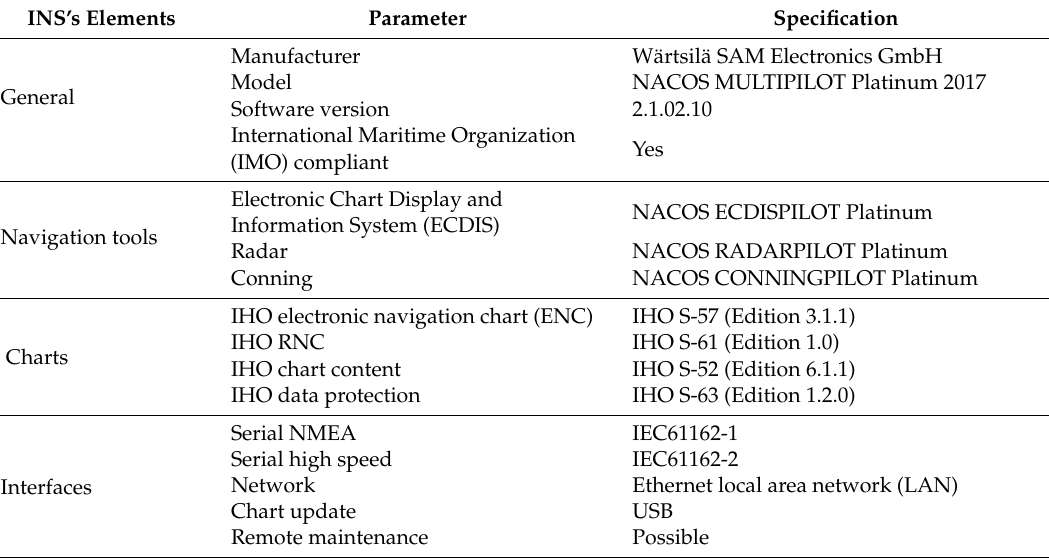
Table 1. The shipboard integrated navigational system (INS) specification.